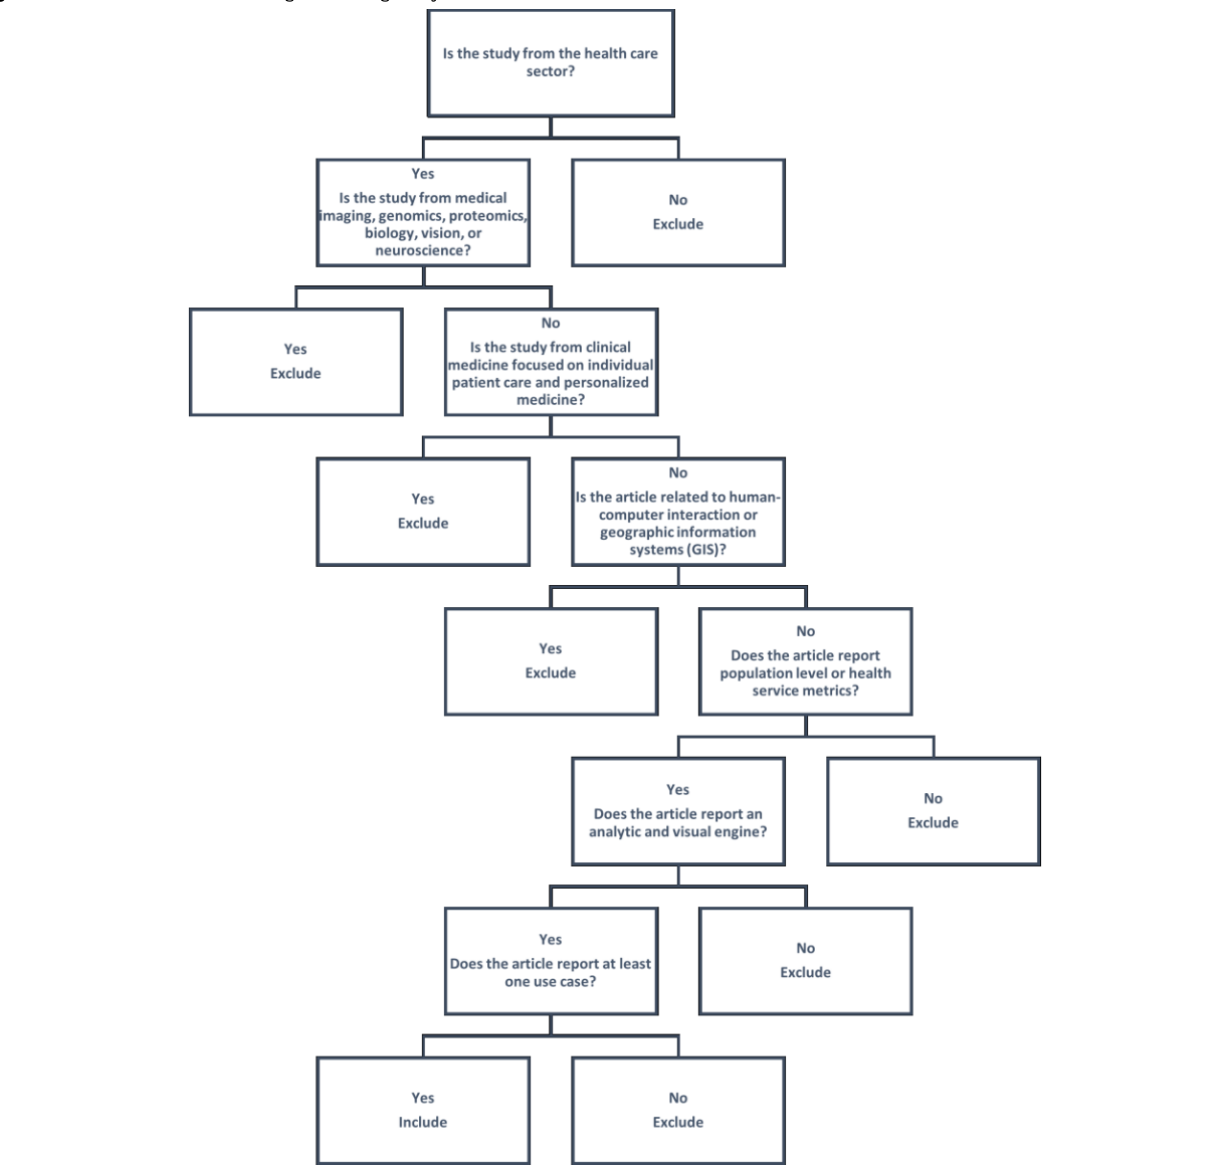
Figure 1. Decision tree for assessing article